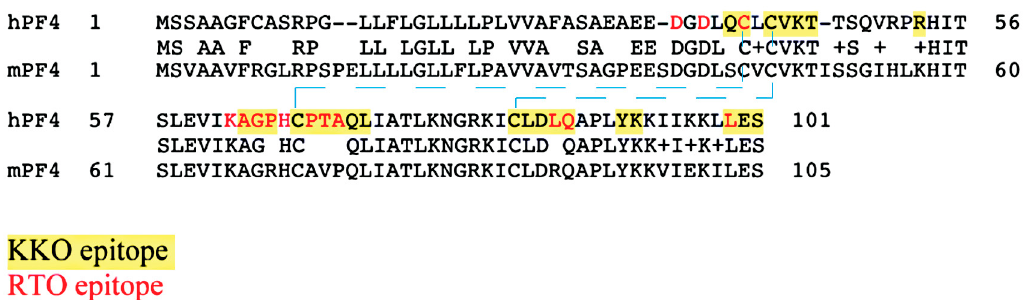
Figure 4. Comparison of human PF4 (hPF4) and mouse PF4 (mPF4) sequences, showing the overlap of KKO and RTO epitopes. Since KKO preferentially binds to PF4 tetramer, its epitopes are contributed by amino acid residues from different chains within a PF4 tetramer. Dash lines depict the internal disulfide bonds.